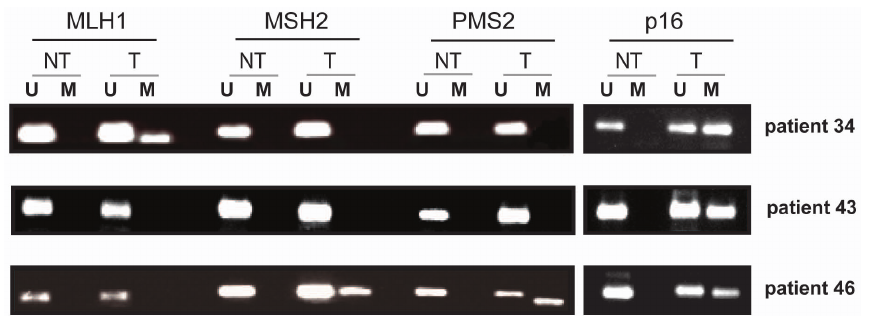
Figure 1. MSP analysis. Representative examples of MSP analysis for MLH1, MSH2, PMS2 and p16 methylation in HCC and non-tumour adjacent tissues were shown. Bisulfite-modified DNA was amplified using MSP primers specific to a CpG-rich region of each gene promoter. PCR-amplified products were resolved by 2% agarose gel electrophoresis. (U) Lanes represent amplification of unmethylated alleles, and (M) lanes contain only methylated alleles.